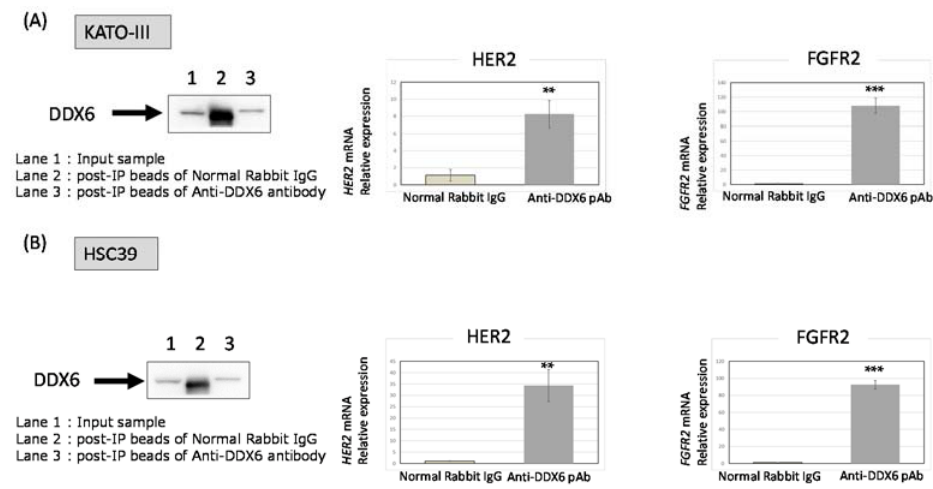
Figure 5. The RIP ‐ assay for KATO ‐ III and HSC39 cells by use of the DDX6 antibody. Immunoprecipitants formed by the anti ‐ DDX6 antibody in the case of KATO ‐ III ( A ) and HSC39 ( B ) cells were evaluated by W.B. for DDX6. Lane 1: Input sample; Lane 2: post ‐ IP beads with normal rabbit IgG; Lane 3: post ‐ IP beads with the anti ‐ DDX6 antibody. Anti ‐ rabbit IgG was used as a negative control. The expression levels of HER2 ( left ) and FGFR2 ( right ) mRNA in DDX6 ‐ RNA complexes were evaluated by RT ‐ PCR in KATO ‐ III ( A ) and HSC39 ( B ) cells. The levels of controls are indicated as “1”. The results are presented as the mean ± SD. ** p < 0.01; *** p < 0.001.